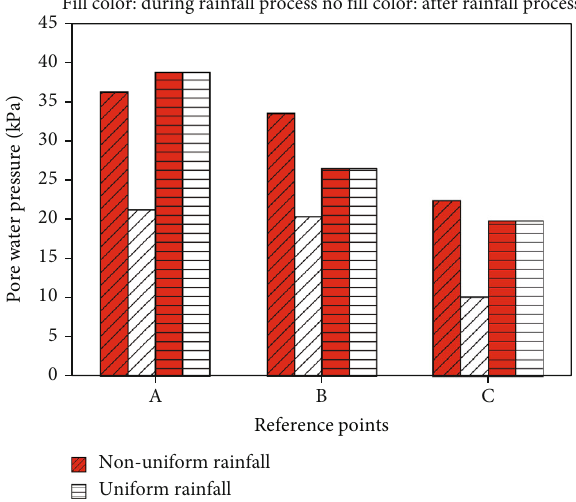
Figure 7: Pore water pressure of reference points.